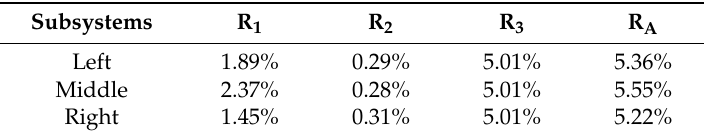
Table 5. Main features of the WiSHiRaPHI